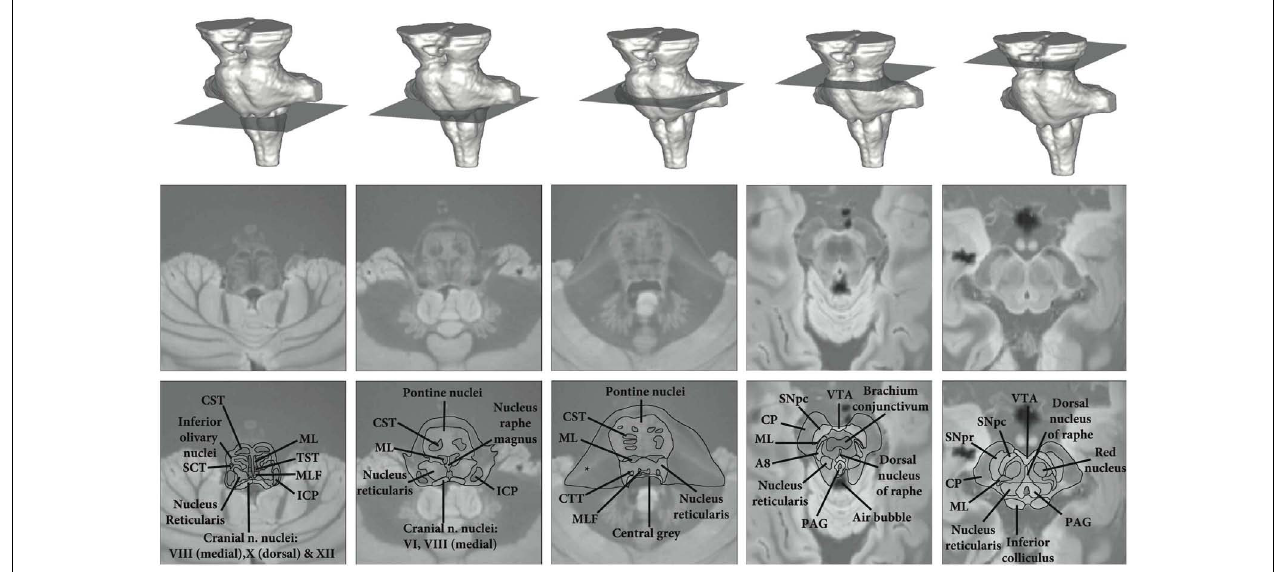
tracts); CST, corticospinal tract; CTT, central tegmental tract; ICP, inferior cerebellar peduncle; ML, medial lemniscus; MLF, medial longitudinal fasciculus; PAG, periaqueductal gray; SCT, spinocerebellar tract; SNpc, substantia nigra pars compacta; SNpr, substantia nigra pars reticulata;TST, tectospinal tract;VTA, ventral tegmental area. * Artifact due to